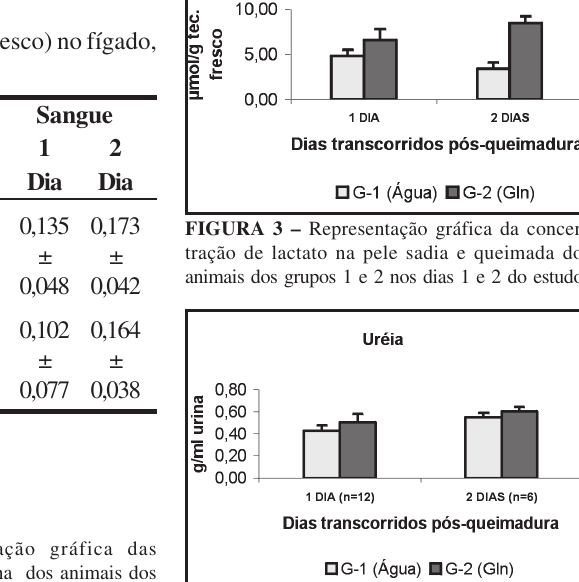
FIGURA 4 – Representação gráfica das concentrações de uréia na urina dos animais